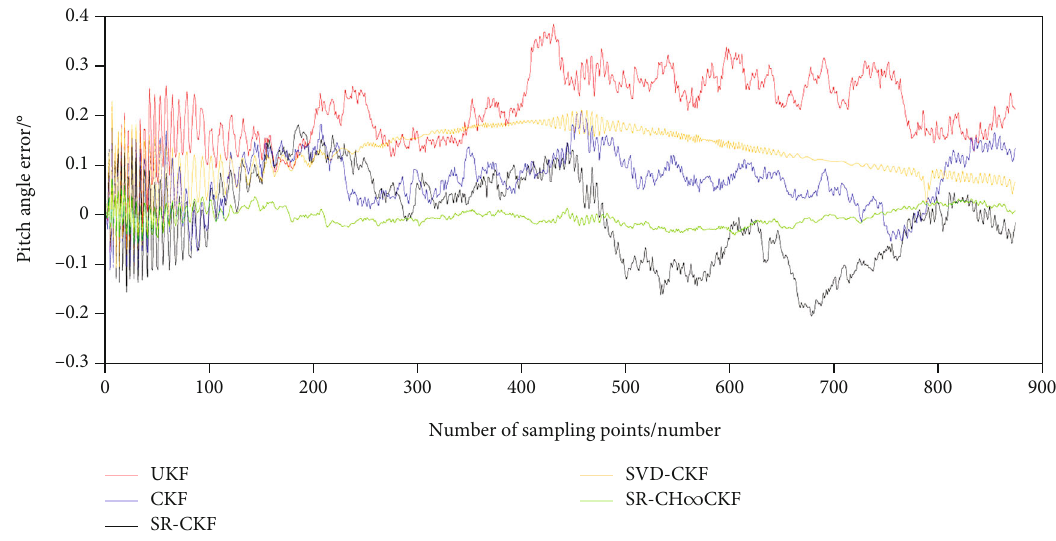
Figure 5: Schematic diagram of pitch angle error